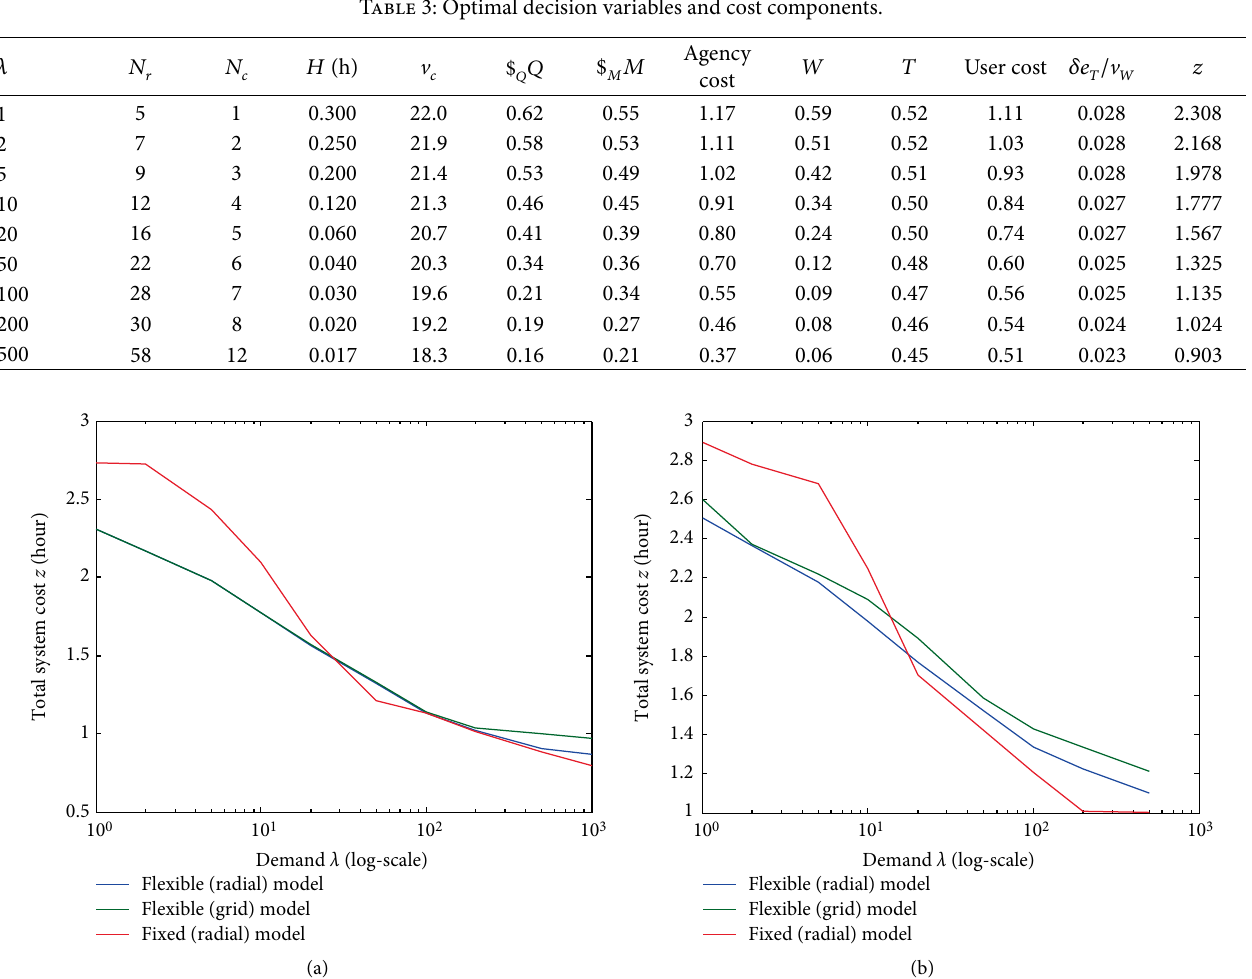
Figure 4: Minimized system cost versus demand density levels. (a) A small city ( 𝐷 = 10 km, 𝑅 = 5.64 km). (b) A mid-size city ( 𝐷 = 20 km, 𝑅 = 11.28